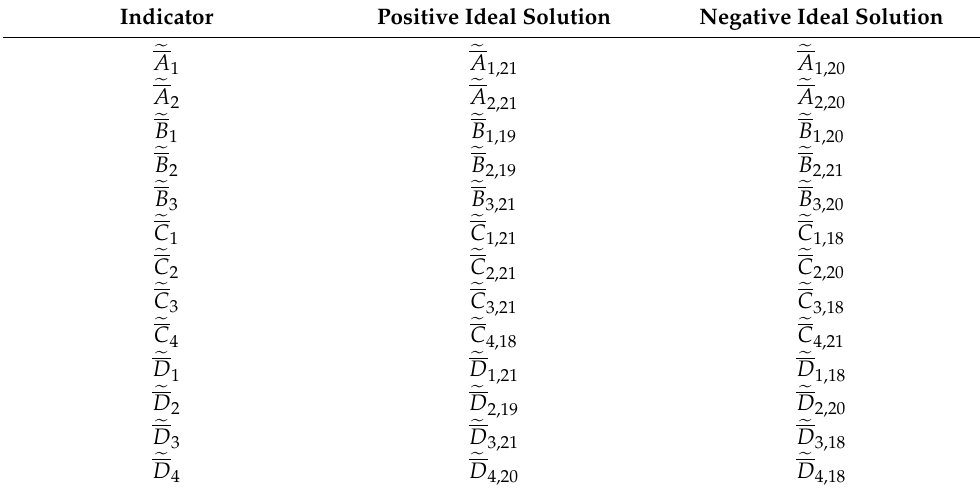
Table 19. Positive and negative ideal solutions for each indicator. Indicator Positive Ideal Solution Negative Ideal Solution